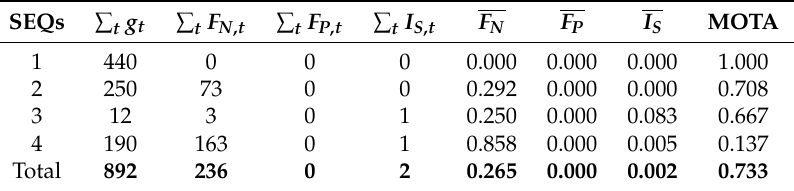
Table 2. Multi-object tracking (MOT) metrics values for the sequences 1, 2, 3 and